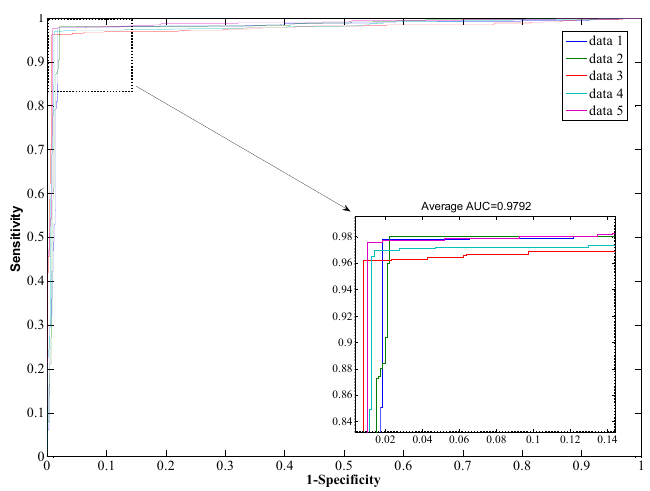
Figure 4. ROC from proposed method result for Human PPI dataset.